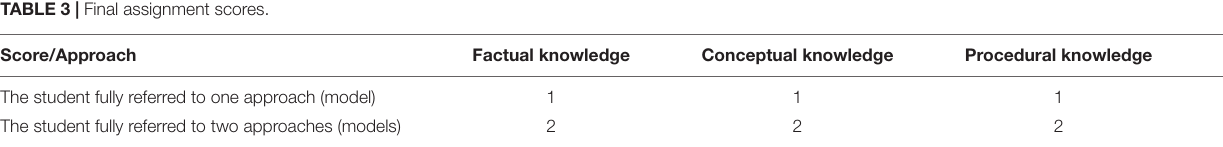
FIGURE 1 | Arguments designed by using a Mindomo concept map. TABLE 3 | Final assignment